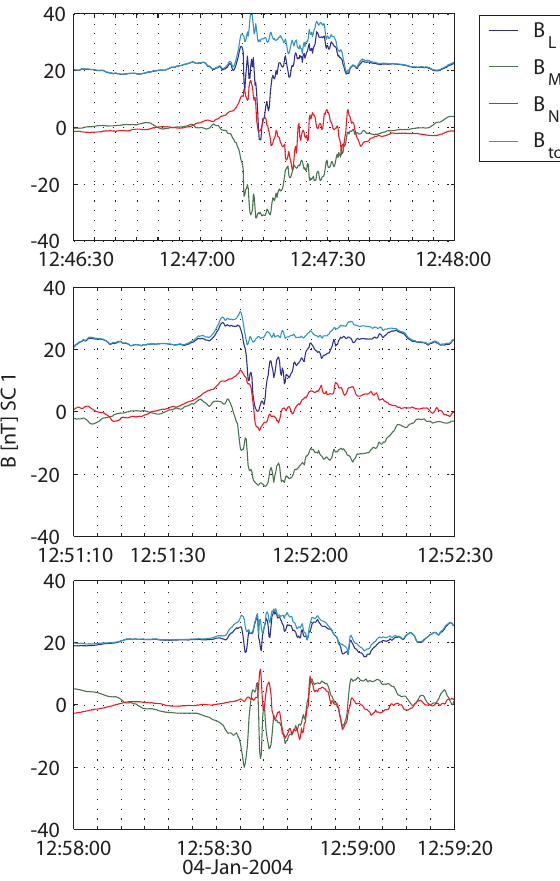
Fig. 4. The magnetic field in local LMN -coordinates from Clus- ter 1 for the events 12:47, 12:51 and 12:58, where B L is dark blue, B M is green, B N is red and B TOT is light blue. The N -direction here is the normal to the magnetopause for the entry into the magne- tosheath at 14:10. This is direction is very similar to the local timing on the parallel current sheet used in the analysis. The L -direction is the local magnetospheric